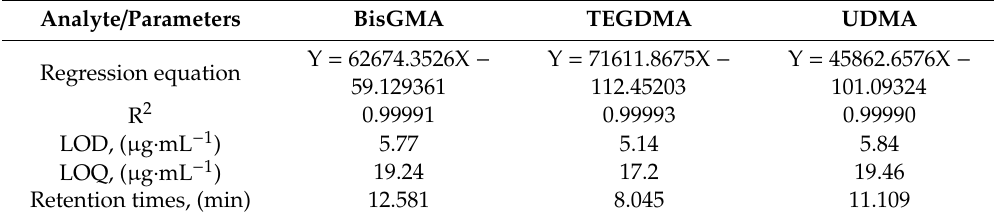
Table 2. HPLC analysis: regression equations of the calibration curves, retention times and detection limits of the investigated compounds at 205 nm and 275 nm (X = quantity of monomer mg / ml; Y = pick area).